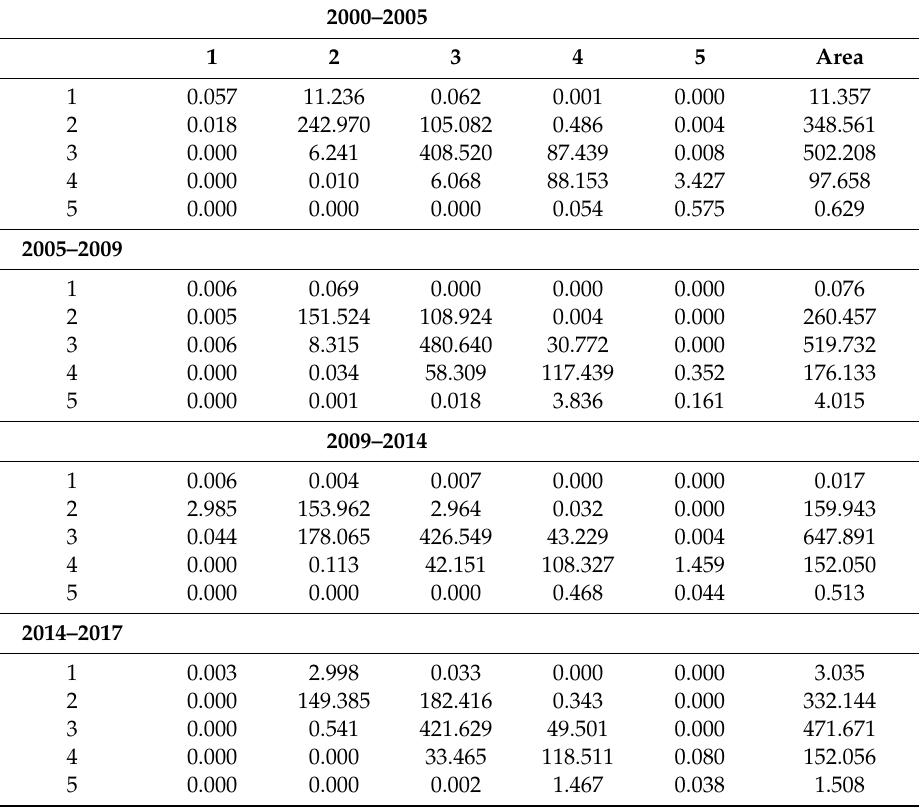
Table 5. Transfer matrix of the RSEI in China in 2000–2017 (million km 2